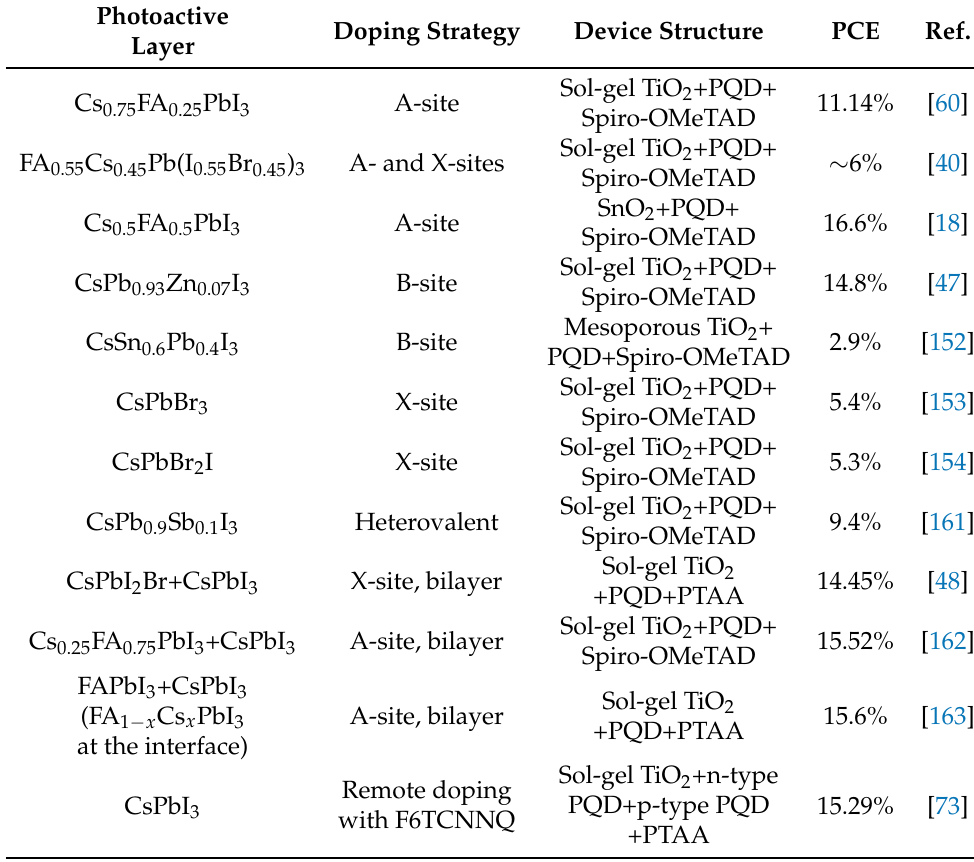
Table 6. Summary of high-efficiency perovskite CQD solar cells by doping